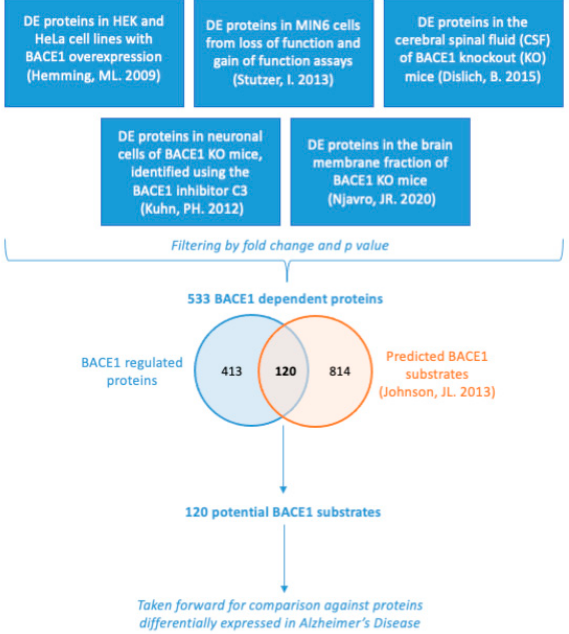
Figure 1. Summary of how the list of 533 BACE1-dependent proteins and 120 BACE1 potential substrates was obtained. Proteomics data from various studies acquired through datamining was filtered by fold change and p value and combined. This list of 533 BACE1-dependent proteins was then compared against a list of 934 bioinformatically predicted BACE1 substrates [37], to give a list of 120 BACE1 potential substrates which was the basis of further analysis